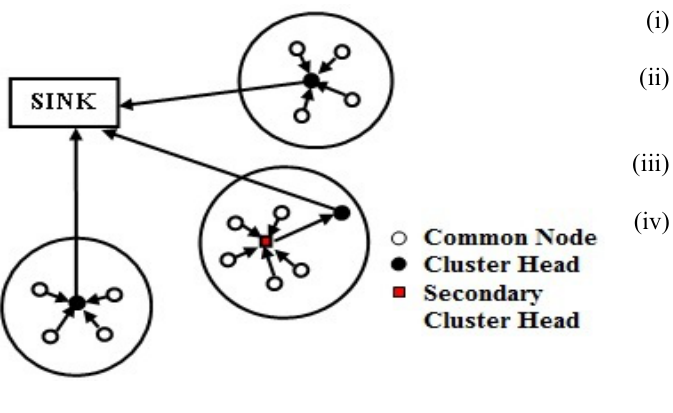
Figure 2. New Routing technique (LEATCH) The LEATCH algorithm time-line process of modern- Secure-WSN as depicted below.